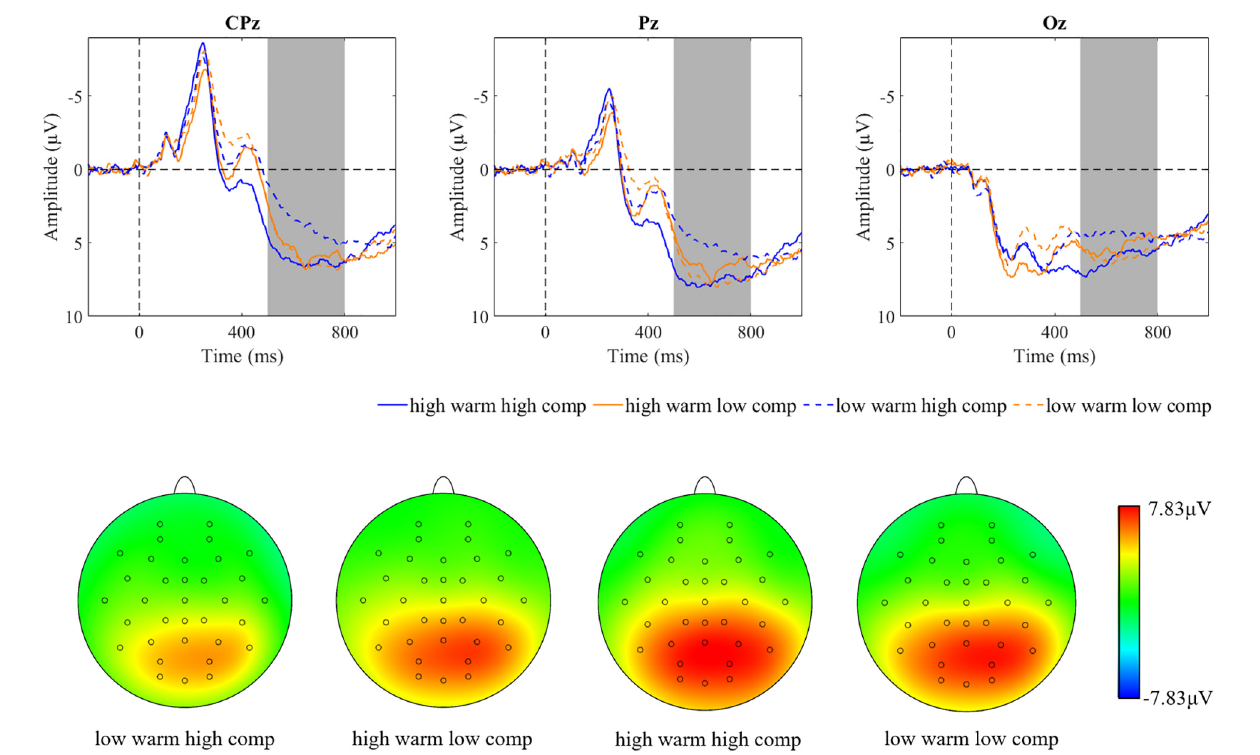
FIGURE 5 | Brainwaves and scalp topographies of the late positive potential (LPP) activity for four categories.